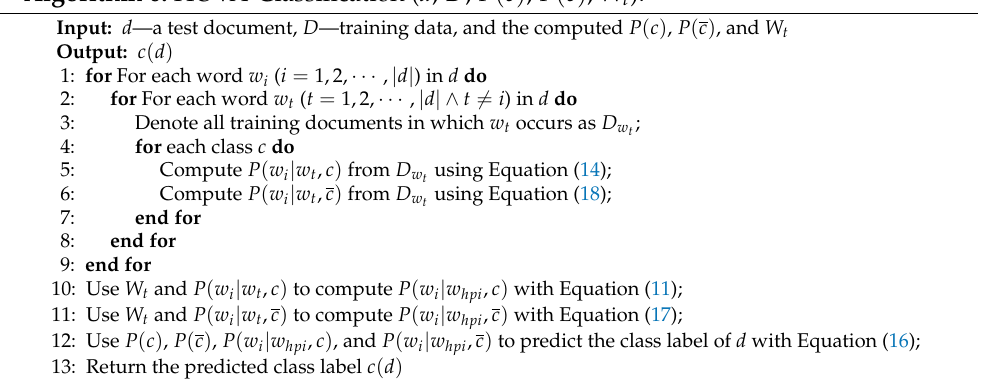
Algorithm 6: HOVA-Classification ( d , D , P ( c ) , P ( c ) , W t